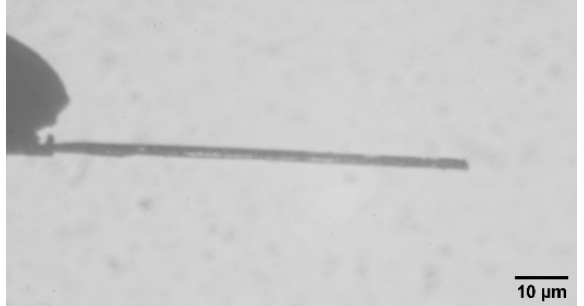
Figure 1. Optical microscopic image of the 2 µm thick [Co(NH 3 ) 5 NO 2 ]Cl(NO 3 ) crystal obtained by etching of a thicker crystal cantilevered to a holder (the edge of the glass capillary can be seen on the left side of the